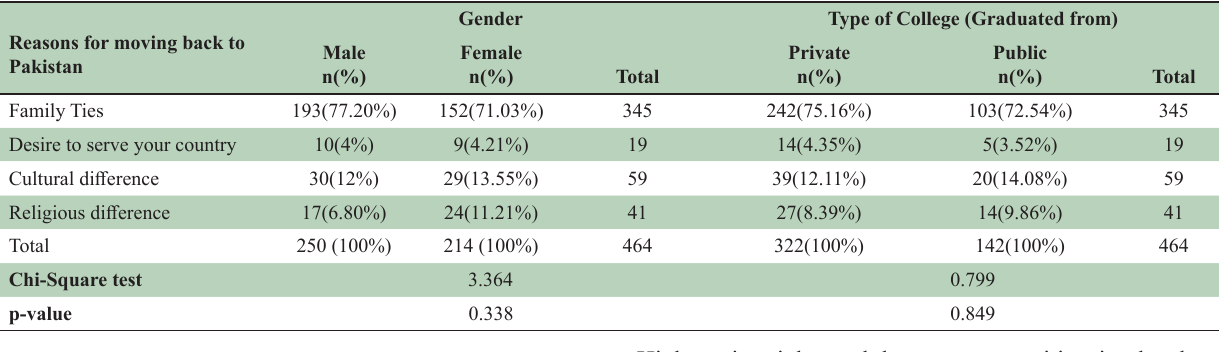
Table-IV: Reasons for moving back with Gender and Type of college (graduated from). Reasons for moving back to